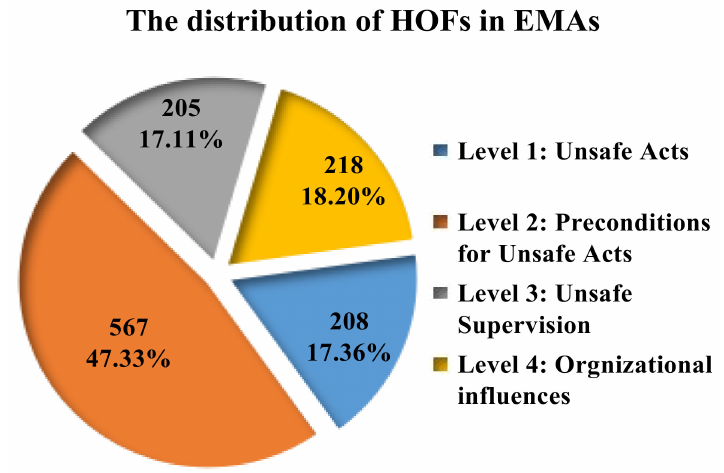
Figure 3. The distribution of the HOFs in EMAs.